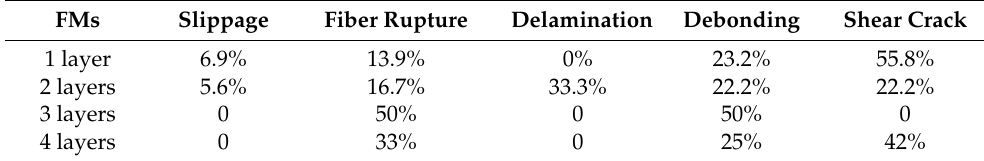
Table 8. The percentage of FMs based on the number of layers.